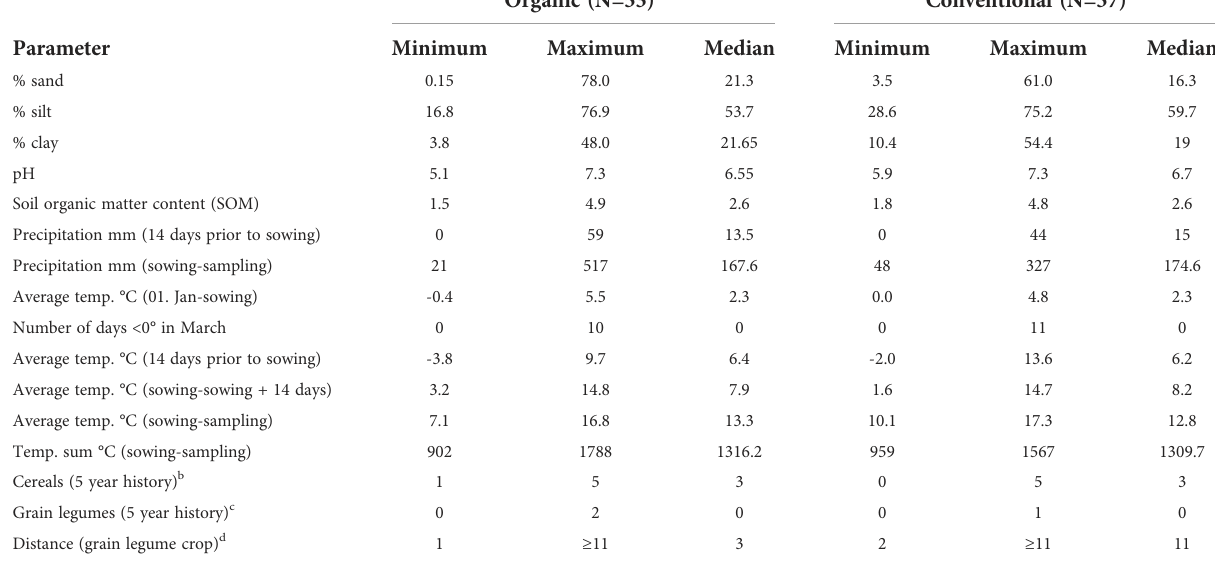
TABLE 1 Range of pedo-climatic conditions for the faba bean fi elds sampled from